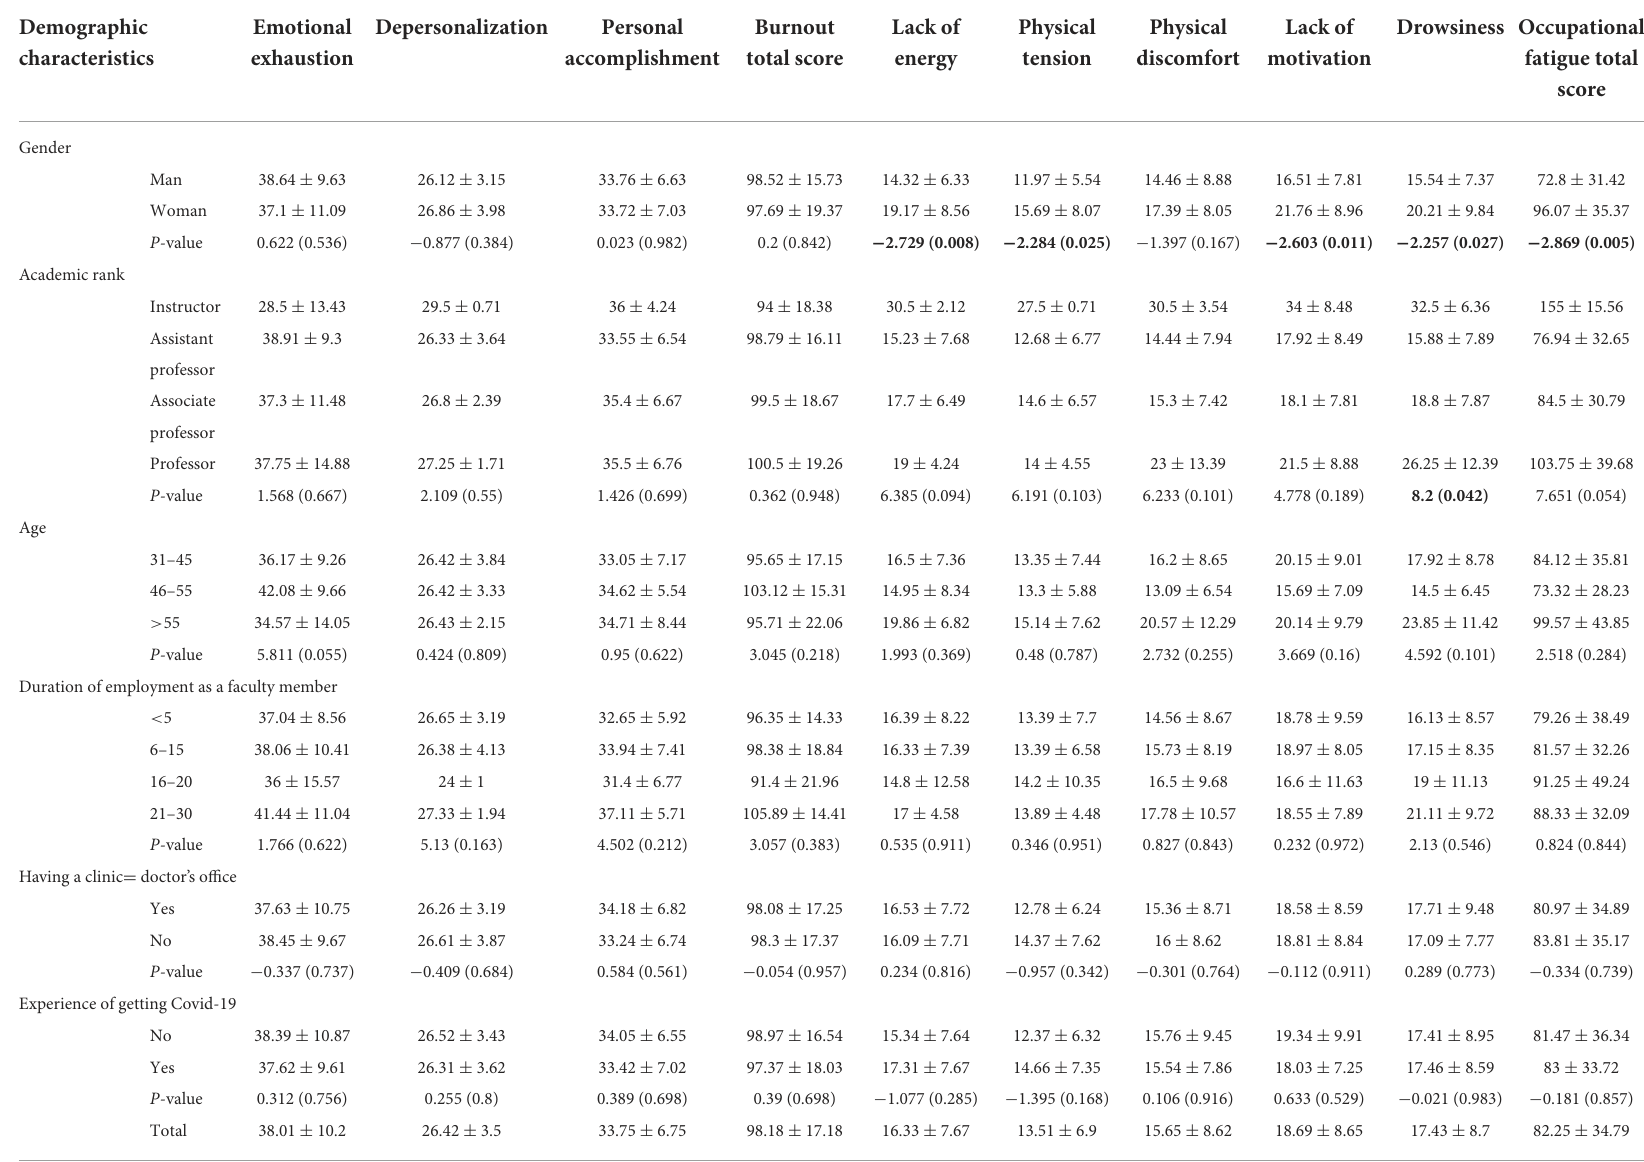
TABLE 2 Descriptive indicators of the main research variables (questionnaires and its various dimensions).